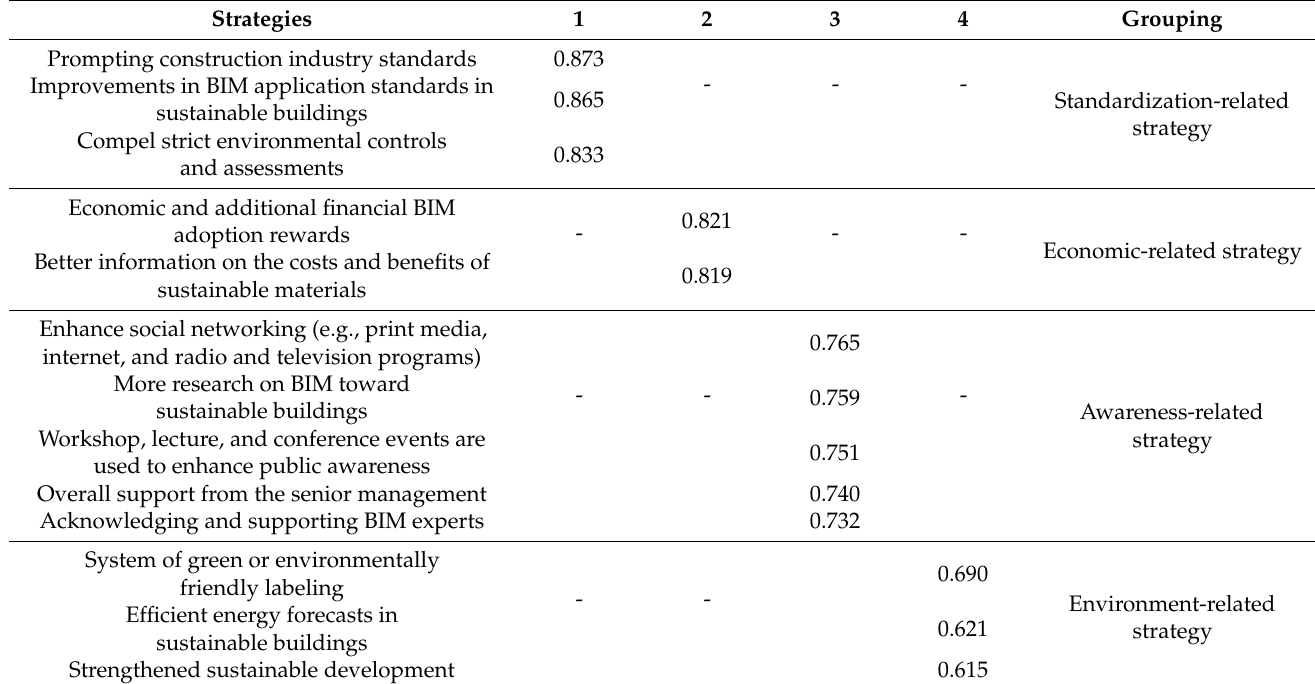
Table 4. Results of the EFA